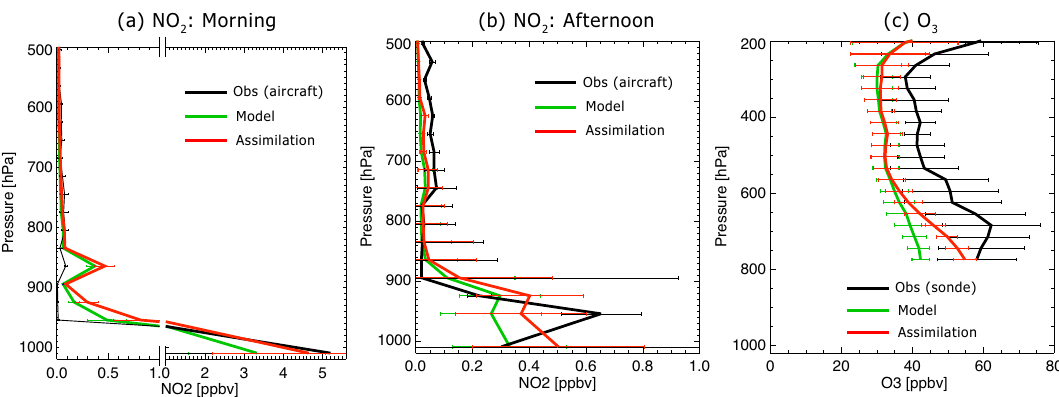
Fig. 11. Vertical profiles of the NO 2 concentrations (in ppbv) in (a) the morning (08:00a.m.–10:00a.m.) and (b) the afternoon (02:00p.m.– 04:00p.m.) and (c) the O 3 concentrations (in ppbv) obtained during the INTEX-B campaign in March 2006. The black lines represent the observed profile; the green lines represent the model simulation; the red line represents the data assimilation run. The error bars represent the standard deviation of all the data within one grid cell.